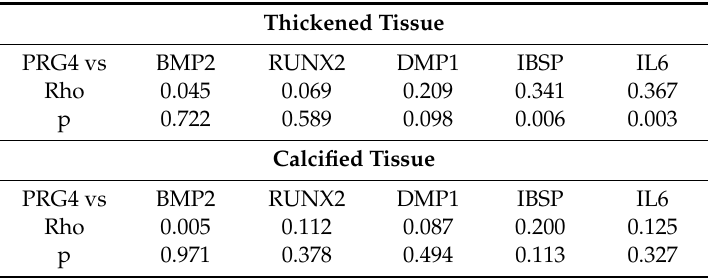
Table 1. Proteoglycan 4 (PRG4) mRNA association in thickened and calcified regions (Spearman correlation coefficient; N = 64) with bone morphogenetic protein 2 (BMP2), dentin matrix acidic